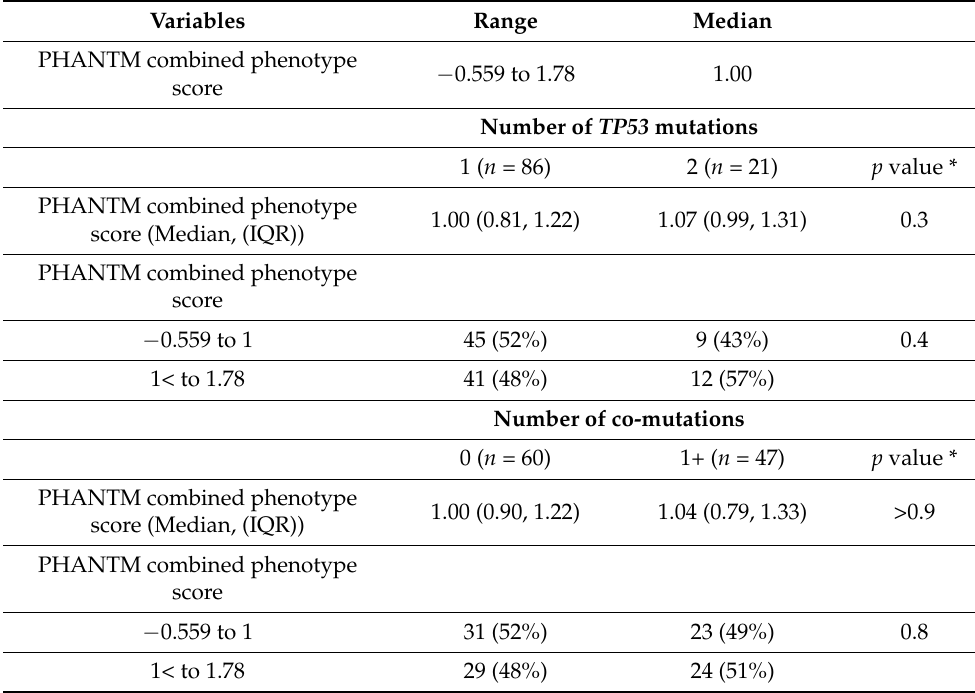
Figure 2. Other co-mutations identified in our cohort. Table 2. PHANTM combined phenotype score ( n =